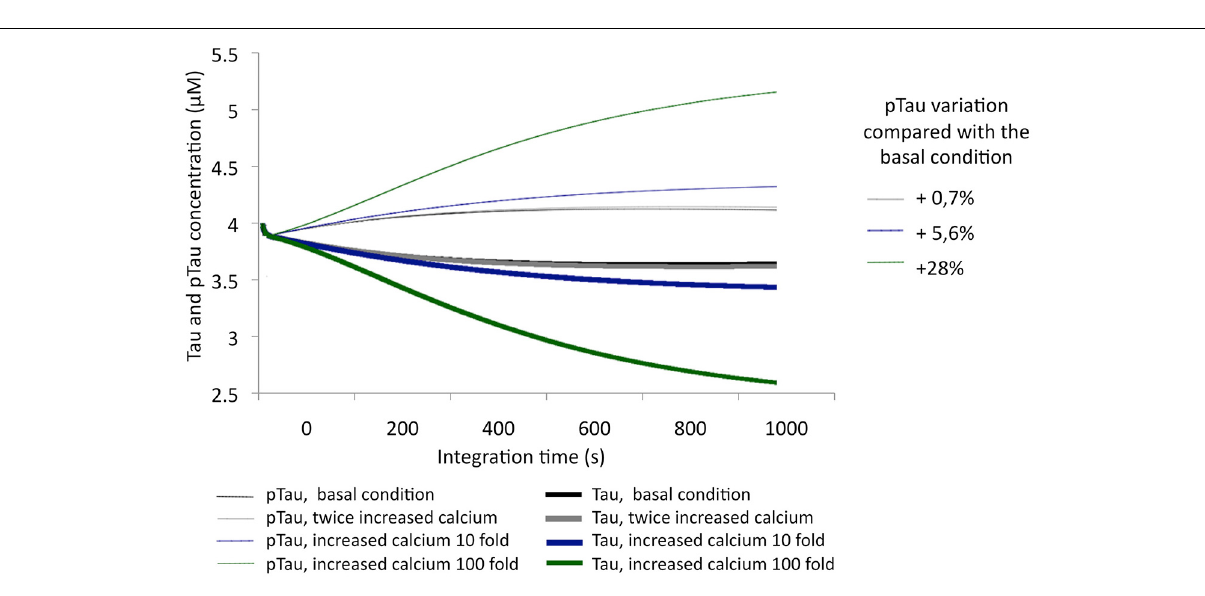
FIGURE 4 | Variation in the levels of Tau and pTau in response to variations in calcium levels. Levels were increased 2-fold (0.2 μ M), 10-fold (1 μ M), and 100-fold (10 μ M). The inset in the graph shows the relative increase of pTau compared with the basal